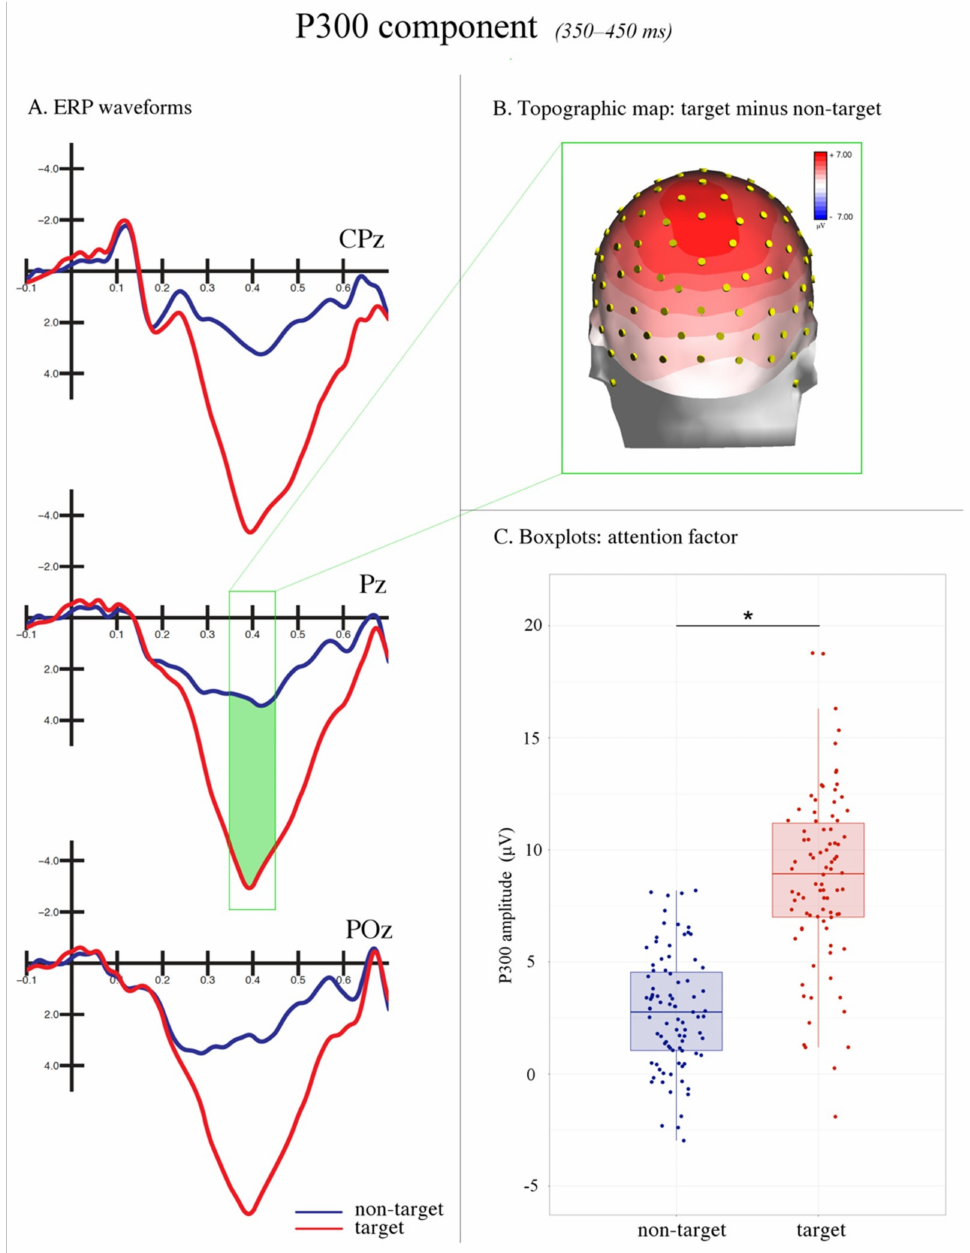
Figure 8. P300 component. ( A ) The grand average ERP waveforms recorded at centro-parietal midline sites. The correctly recognized targets (in red) relative to non-target stimuli (in blue) elicited a larger P300 response between 350–450 ms (area highlighted in green). ( B ) The topographic map (back view) of voltage distribution in the P300 time window (350–450 ms) computed as the di ff erence wave target minus non-target. The positive values are represented in red, while the negative values are represented in blue. ( C ) The boxplots relative to the significant main e ff ect of the attention